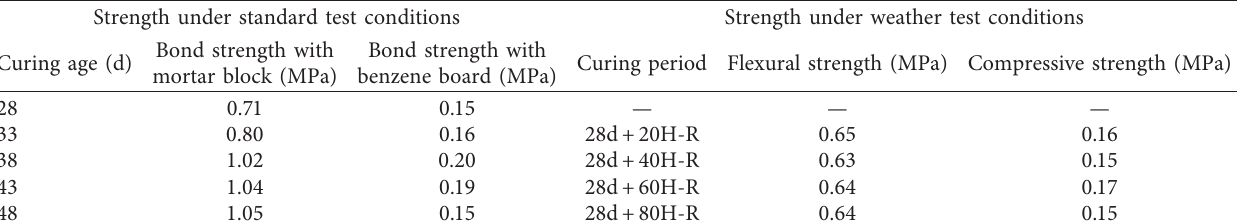
Strength under weather test conditions